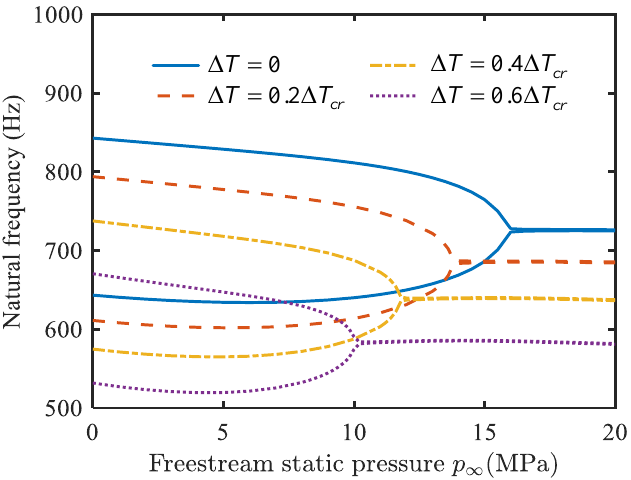
Figure 12. Influence of temperature change on critical free-stream static pressure ( p = 1).